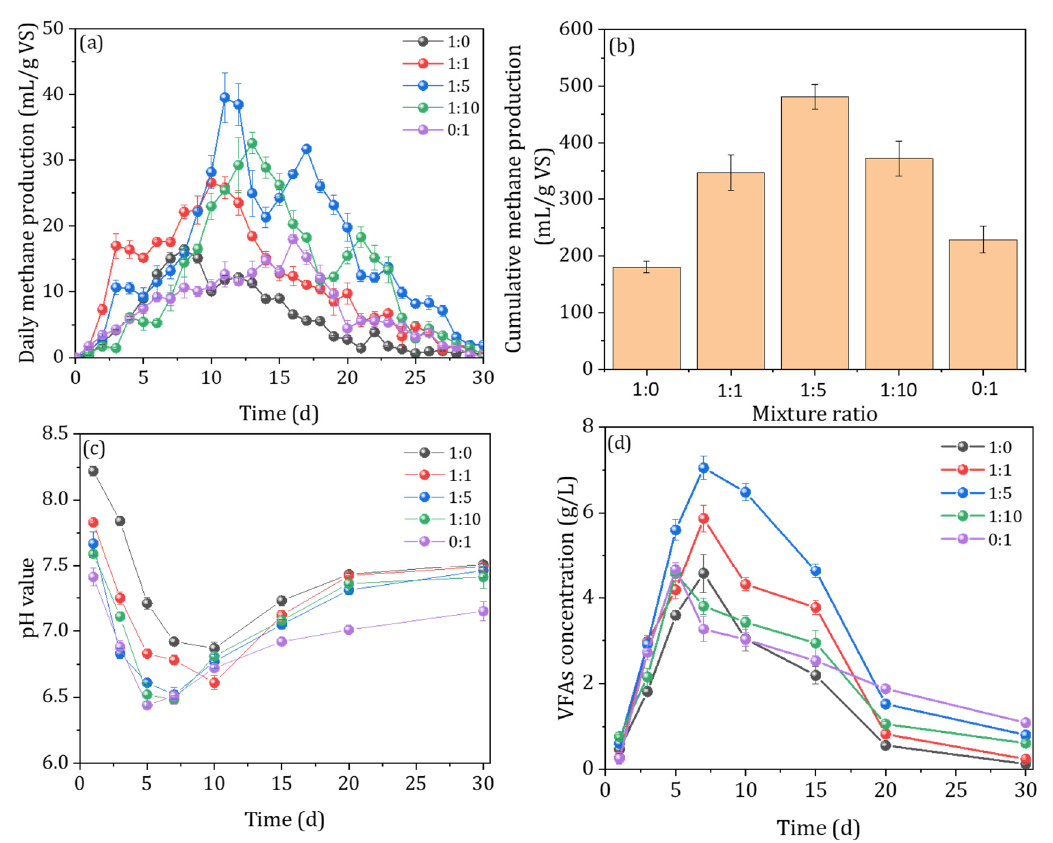
Figure 2. The daily methane production ( a ), cumulative methane production ( b ), the evolution of pH value ( c ), and VFA concentration ( d ) under different mixture ratios, 8% TS content, and 15% inoculum amount.